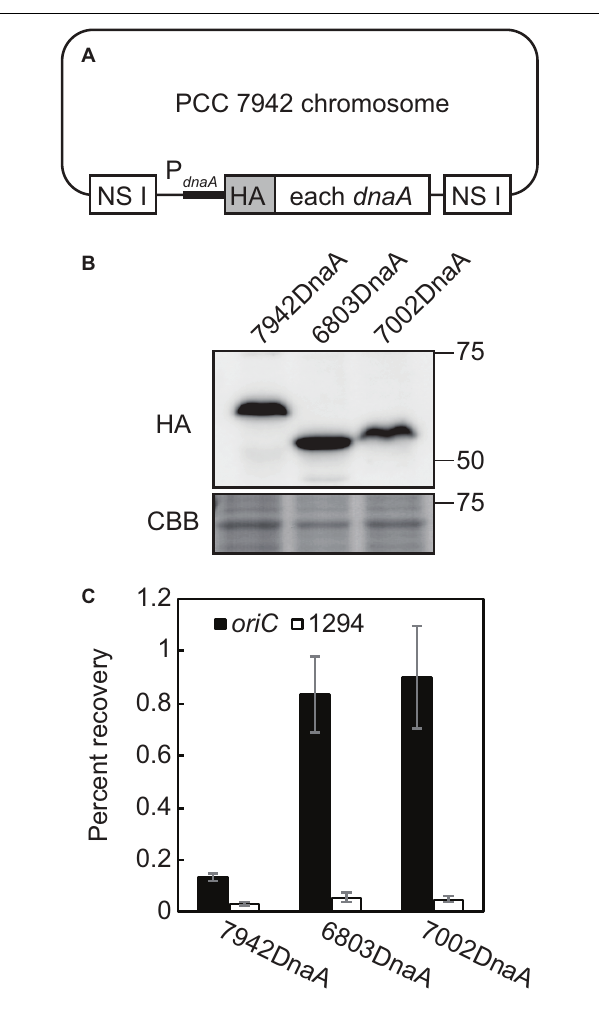
FIGURE 6 | Binding of DnaA to the DnaA-boxes of Synechococcus elongatus , Synechocystis sp. PCC 6803, and Synechococcus sp. PCC 7002. (A) Diagram of the S. elongatus chromosomes expressing HA-tagged DnaA of S . elongatus (7942 DnaA), Synechocystis (6803 DnaA), and Synechococcus 7002 (7002 DnaA). DNA encoding the respective DnaA was integrated into the chromosomal neutral site I (NS I) of Synechococcus elongatus. HA-DnaA expression was driven by the promoter of S . elongatus dnaA . (B) Immunoblot analysis of the expression of HA-DnaA in S . elongatus . Total proteins were subjected to immunoblotting using an anti-HA antibody. Coomassie Brilliant Blue (CBB)-stained proteins are shown as a loading control. (C) ChIP-qPCR analysis of the affinity of the binding of DnaA to the oriC region (DnaA-boxes) of the S . elongatus chromosome. The DnaA-chromatin complex was immunoprecipitated using an anti-HA antibody. The samples were quantified using qPCR with the primers representing the oriC region ( oriC : solid bar) and Syf1294 , which is farthest from oriC in the circular chromosome and lacks a DnaA-box sequence (1294: open bar). The percent recoveries of input DNA are indicated with the standard deviation ( n = 3 biological